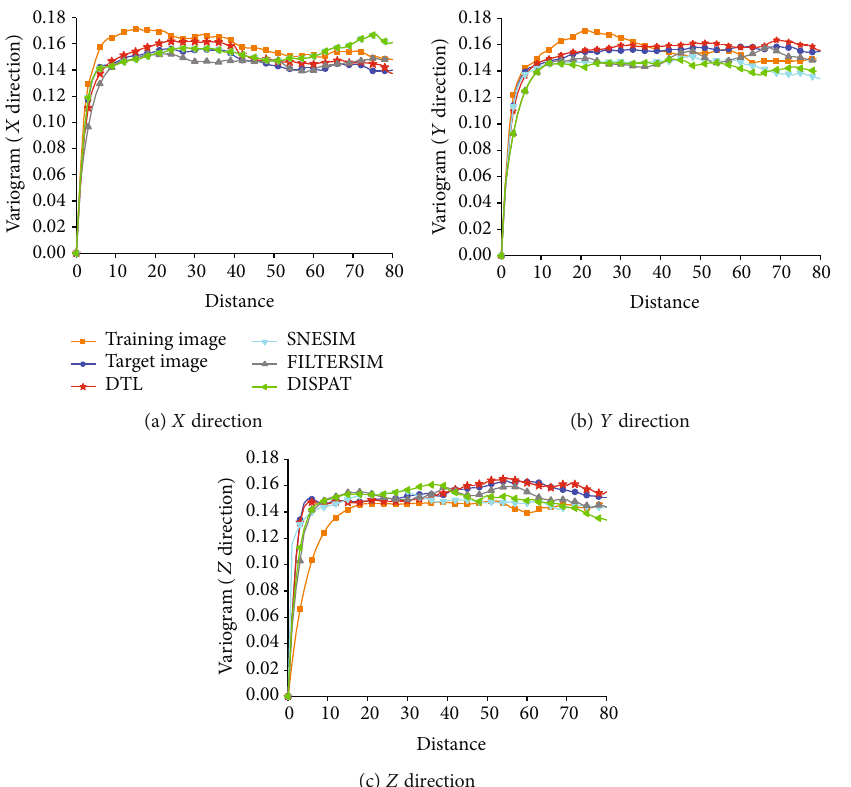
Figure 18: Variogram curves of shale images from the TI, the target image, and reconstructed images using SNESIM, FILTERSIM, DISPAT, and DTL in three